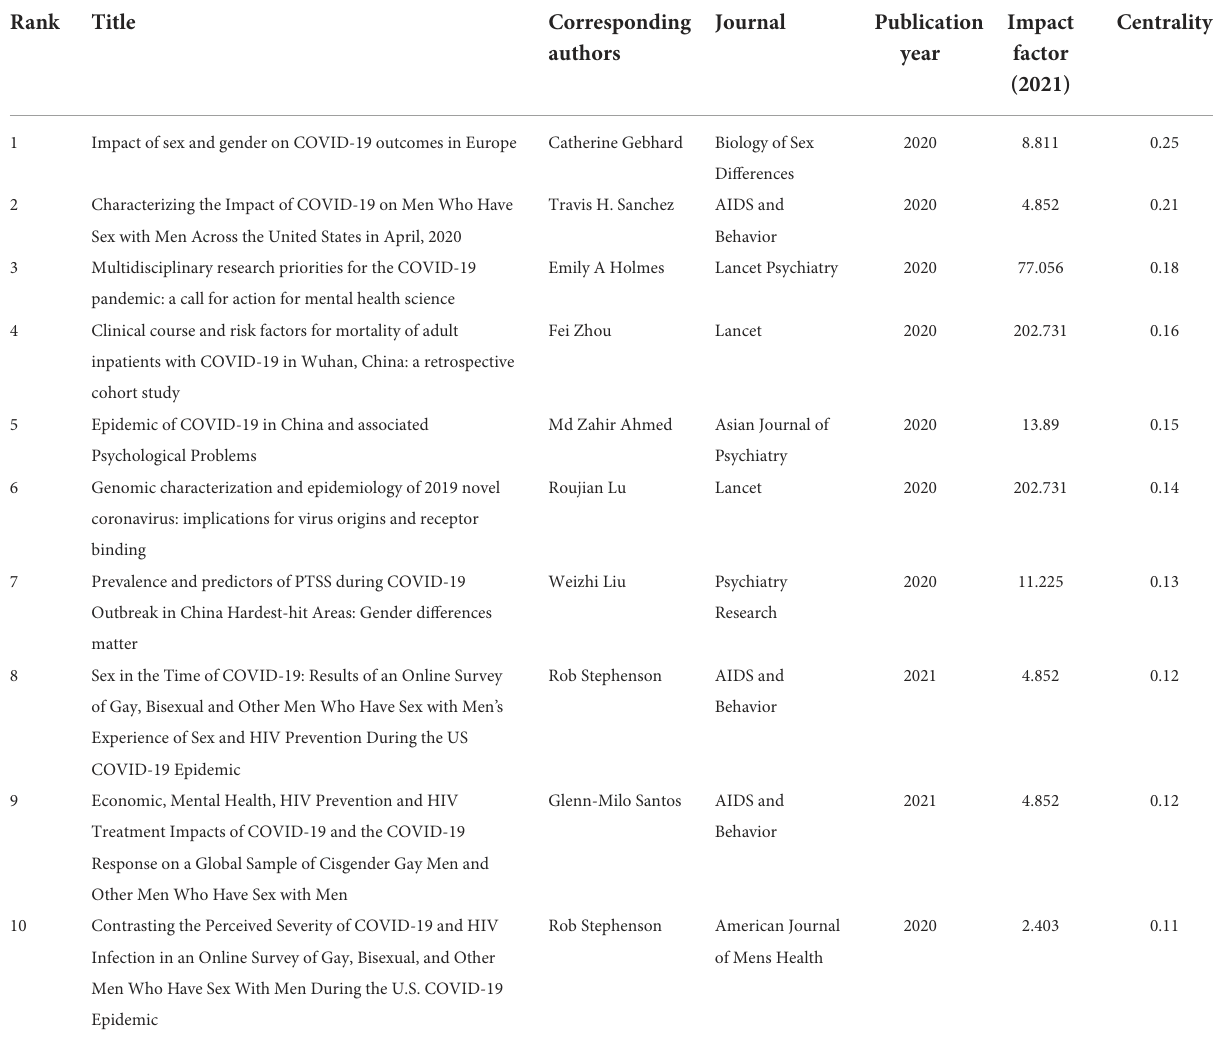
TABLE 5 Top 10 cited references by the highest